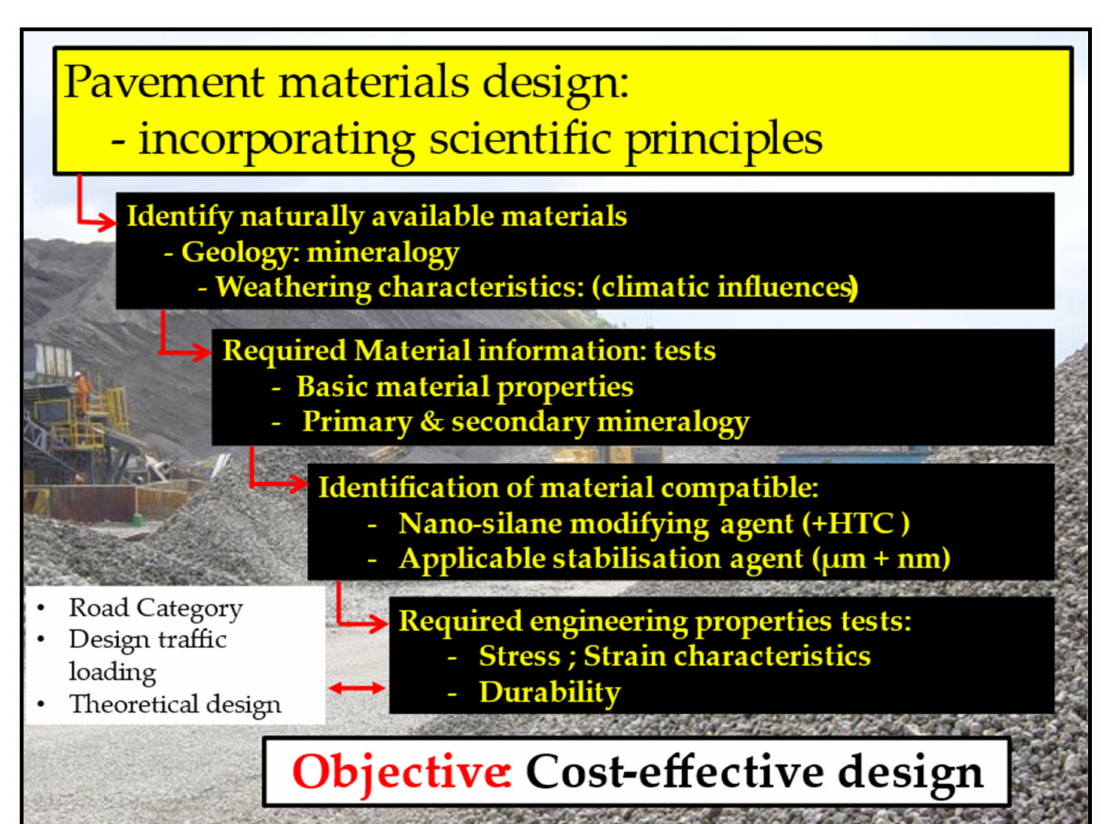
Figure 1. Recommended basic approach to road pavement materials design incorporating scientifically based concepts, developed for the selection of a material-compatible New-age (Nano) Modified Emulsion (NME) stabilising agent addressing the engineering requirements (physics) of a road pavement